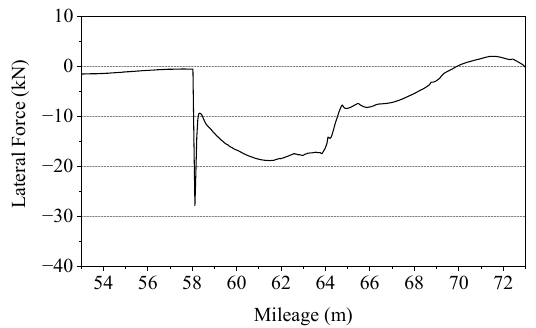
Figure 3. The typical working condition.